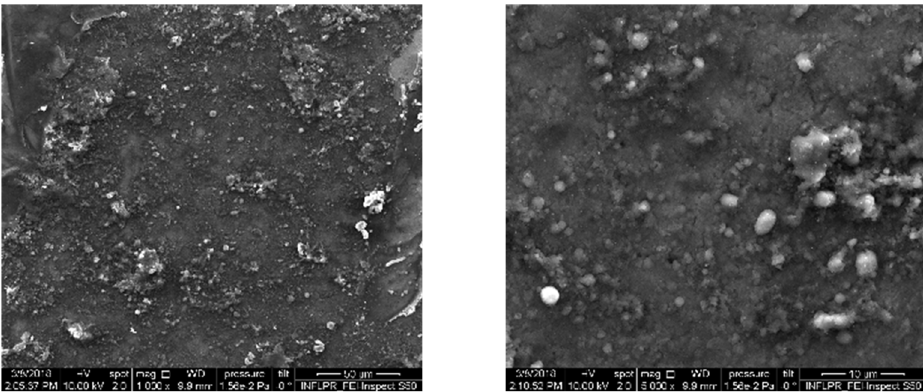
Figure 6. SEM images of BG+CIPRO/PMMA thin films after 21 days of immersion in SBF, at different magnifications.